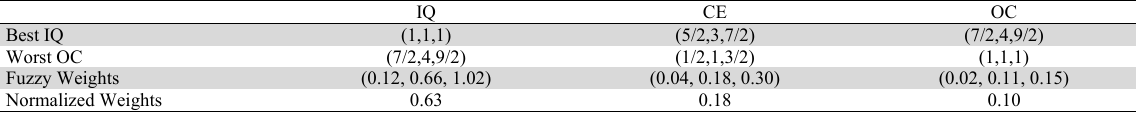
Best-Worst value for the Sub-group 3